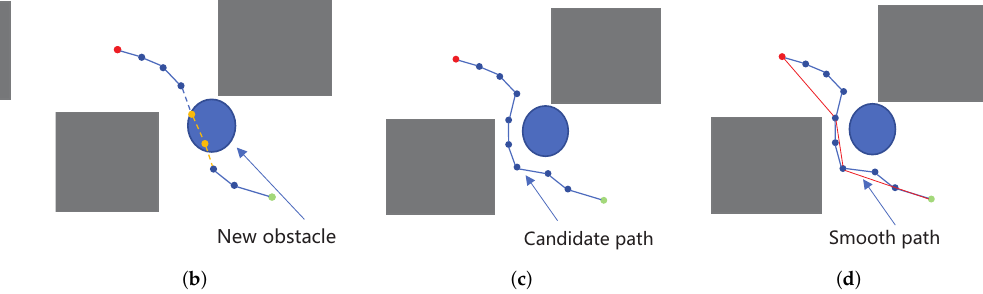
Figure 4. Given the start and goal points (shown in green and red dot), a path can be found through the graph search algorithm in a two-dimensional (2D) environment ( a ). When a new obstacle (blue ellipse) appears in the environment, the nodes and edges of the constructed graph structure will partially invalid (shown in yellow) ( b ). The planning problem is completed by searching the candidate path (ignoring the invalid nodes and edges when querying and searching path using other nodes and edges in the graph) ( c ). The path is further optimized by removing redundant states from the path (shown in red line) ( d